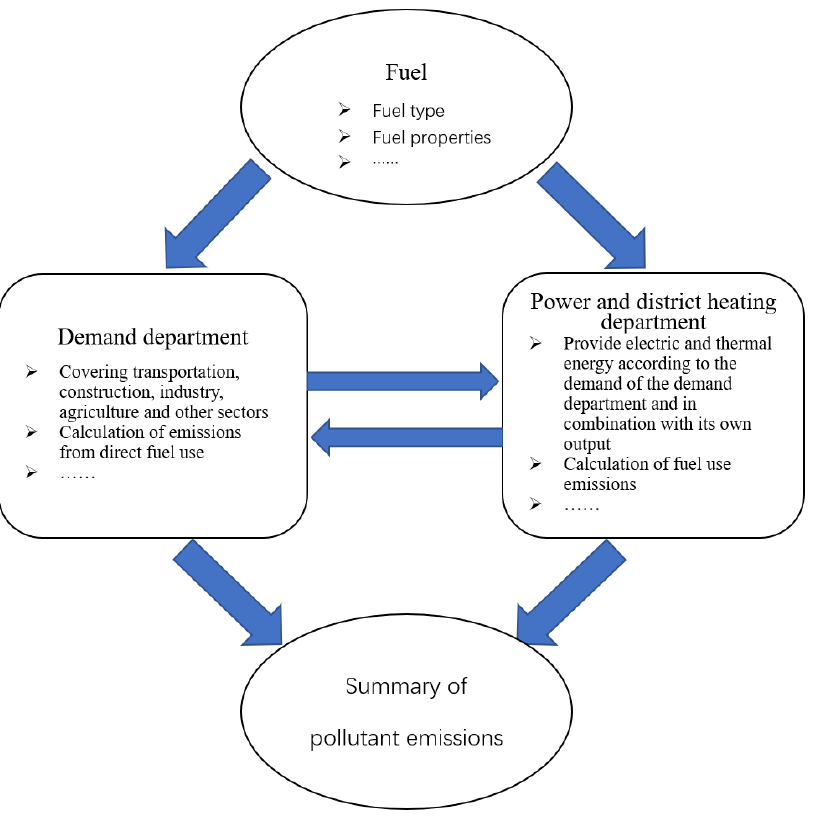
Figure 2. Overview of the “fuel-sector-use emissions” process.